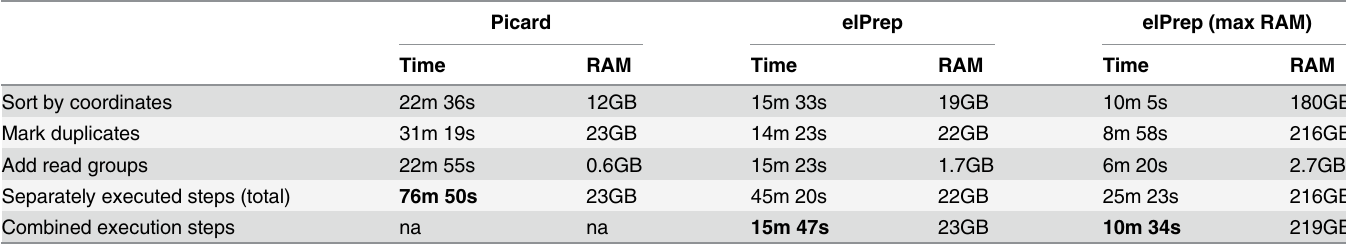
Table 2. Benchmarks of the 3-step pipeline on NA12878 exome (Support protocol